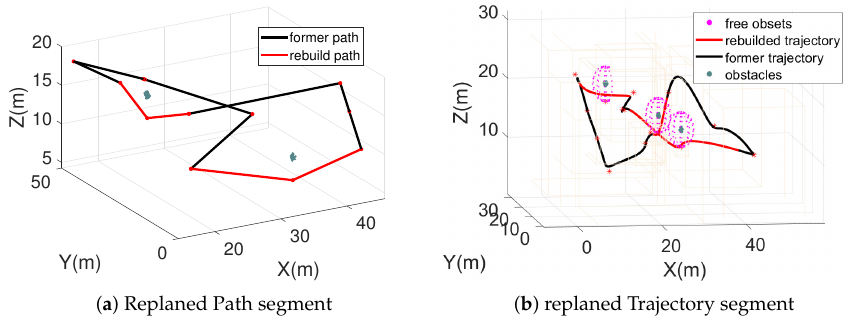
Figure 20. Details of the replanned trajectory and path. Collision-free spots on the free sphere around obstacles are illustrated as free obsets. The number of spots in the obstacle set was 49. Each iteration of R 100 spots on the collision-free sphere was